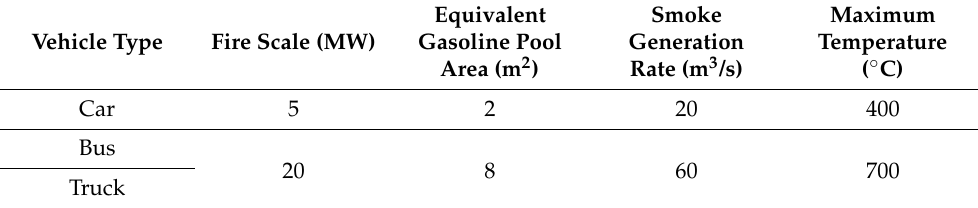
Table 3. Fire scale, flue gas productivity, flue gas temperature of different vehicle types.